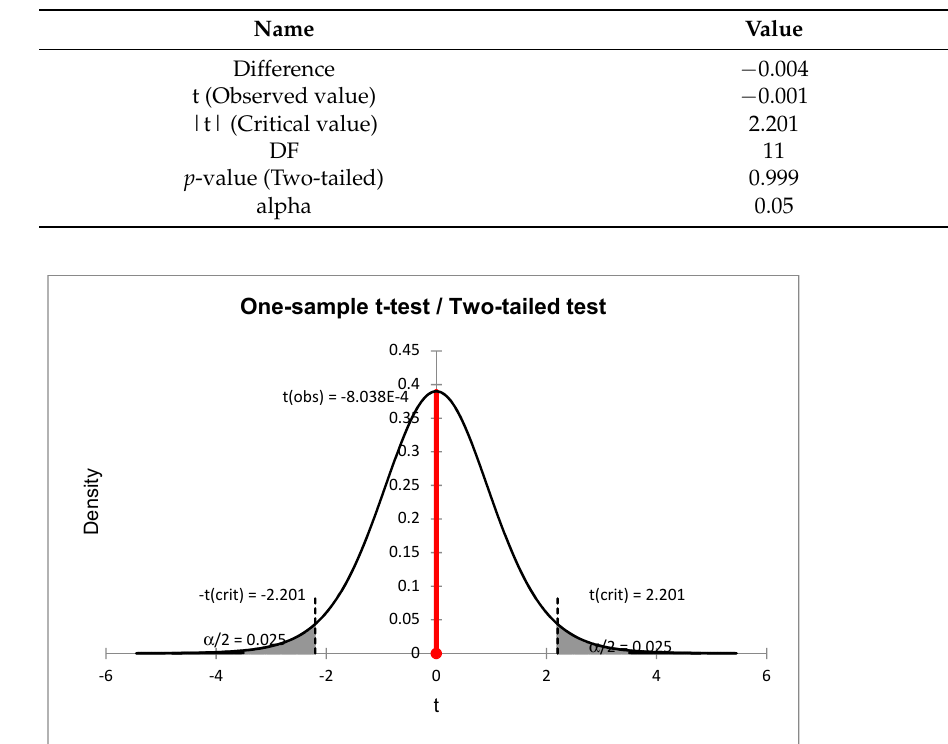
Table 6. Model parameters.